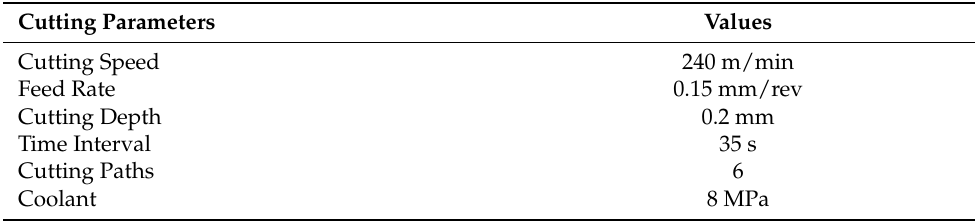
Table 4. Parameters applied in turning experiments.